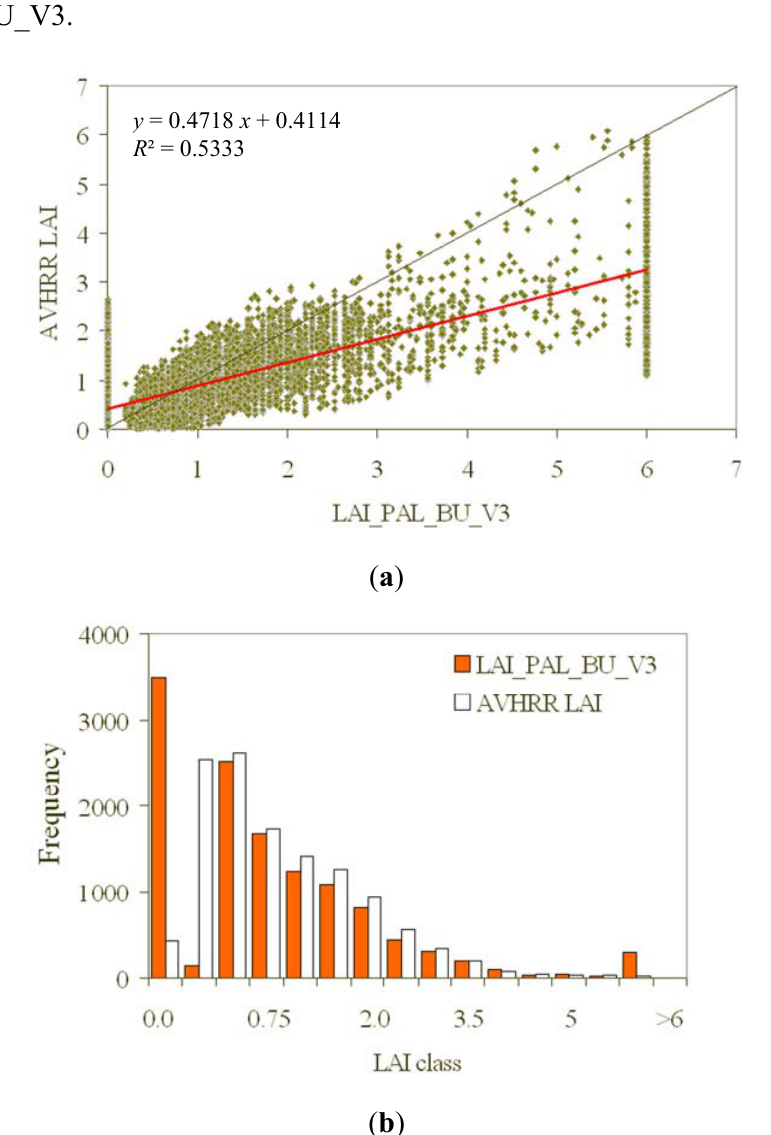
Figure 7. Comparison of the AVHRR LAI to LAI_PAL_BU_V3. ( a ) Pixel-by-pixel comparison of the AVHRR LAI map and the LAI_PAL_BU_V3 product over the whole area of Kazakhstan for July 2008. ( b ) Frequency distribution of the AVHRR LAI and LAI_PAL_BU_V3.